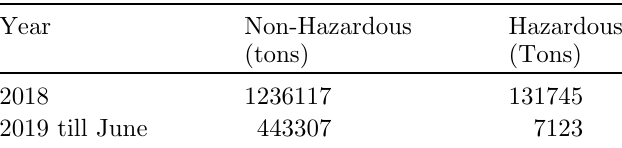
Table 2. Waste accumulation in Ajman in tons (2018 – 2019)